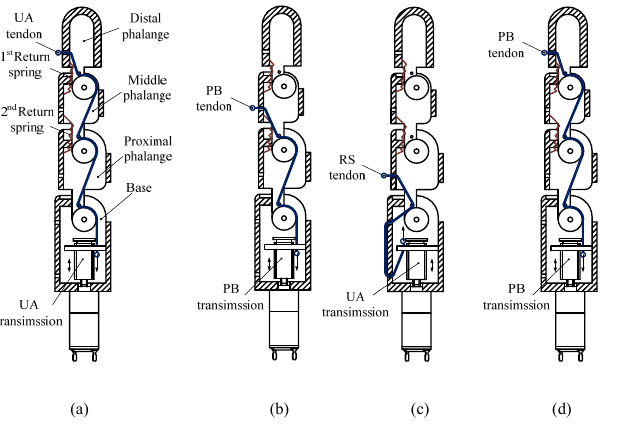
Fig. 3 Assembly method of finger’s tendons. a) UA tendon; b) PB tendon; c) RS tendon; d) Figure 3. Assembly method of finger’s tendons. (a) UA tendon; another assembly method of PB tendon. (b) PB tendon; (c) RS tendon; (d) another assembly method of PB tendon.